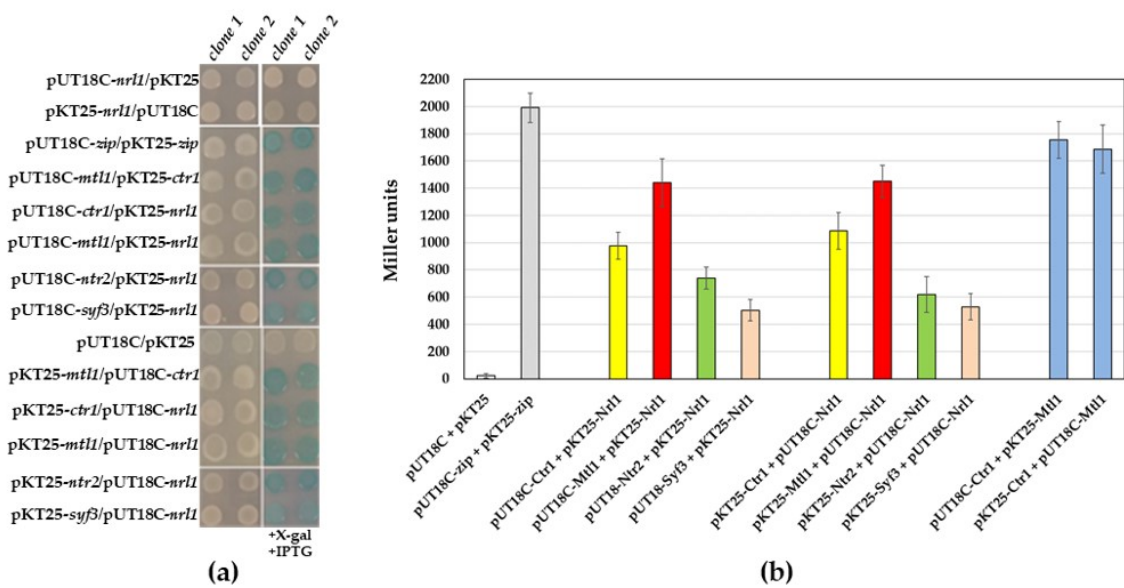
Figure 1. Physical interactions between Nrl1 and selected RNA-processing factors analyzed by the BACTH assay. ( a ) In vivo protein–protein interaction studies of Nrl1 and RNA-processing factors Ctr1, Ntr2, Syf3, and Mtl1 helicase. The nrl1 , ctr1 , mtl1 , ntr2 , and syf3 were sub-cloned into the pUT18C and pKT25 plasmids. E. coli cells transformed with the indicated constructs were plated on standard LB agar plates and LB agar plates containing X-gal and IPTG. The pUT18-zip and pKT25-zip plasmids and interactions between the Ctr1 and Mtl1 were used as positive controls. As negative controls, the empty vectors pUT18C and pKT25 were used. ( b ) Intensities of interactions between the studied proteins were evaluated by β -Galactosidase activity assay. Quantification of β -galactosidase activities of transformants are shown in Miller units. Data represent mean values ± S.D. from eight independent biological replicates.